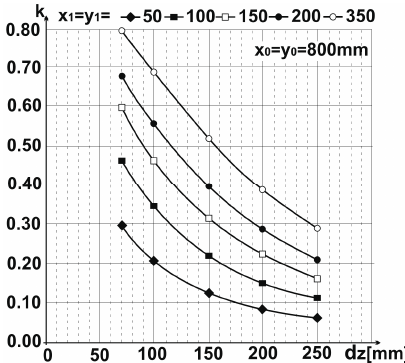
Figure 3. The effect of distance and IPT dimensions upon coupling coefficient (k). Figure 3. The e ff ect of distance and IPT dimensions upon coupling coe ffi cient